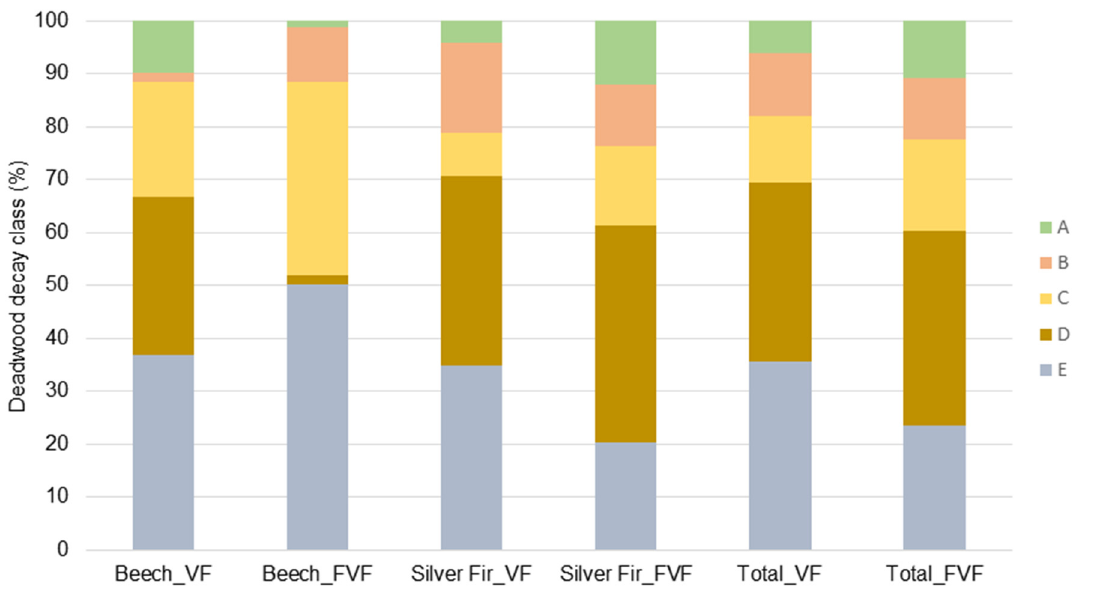
Figure 3. The deadwood structure on decay class (A—fresh, B—hard, C—rotten, D—mouldering, E—mull wood), species, and forest type (VF—virgin, FVF—former virgin forests).